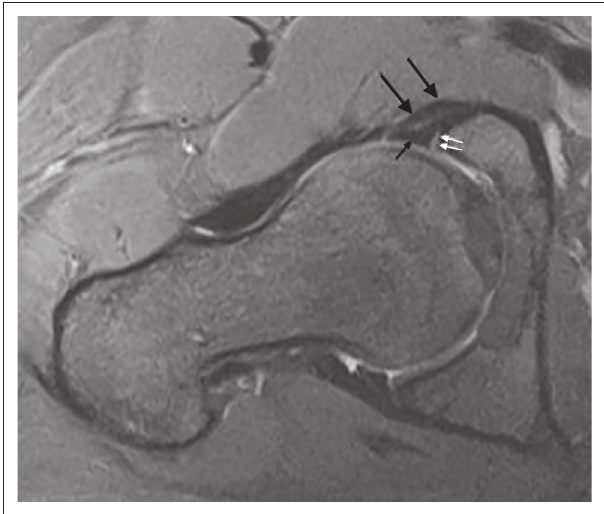
FIGURE 2: Axial oblique PDFS image of the right hip. Detachment (short white arrows) of the anterior labrum (short black arrow) which on consecutive images was full thickness. The overlying psoas tendon (long black arrows) ‘dips’ laterally, raising suspicion of psoas